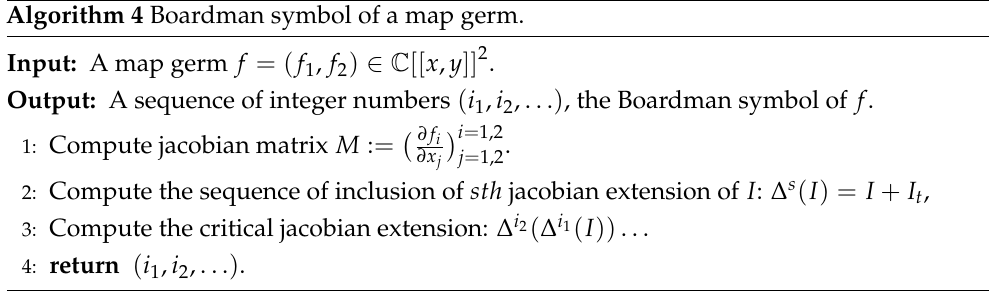
Algorithm 4 Boardman symbol of a map germ.